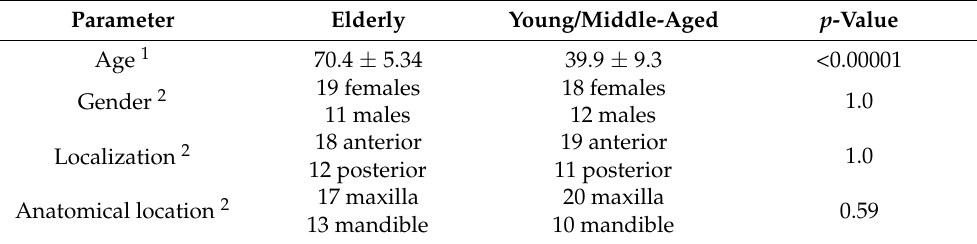
Table 1. Demographic and clinical characteristics of young/middle-aged and elderly patients.